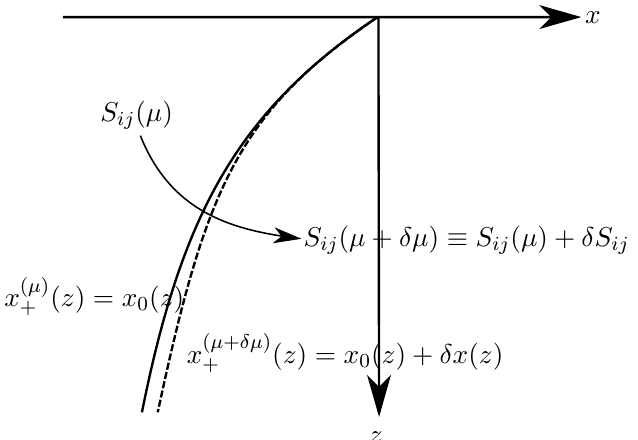
Figure 4 . Geometric setup for the proof of volume loss along a boundary RG (cid:13)ow parametrised by (cid:22)